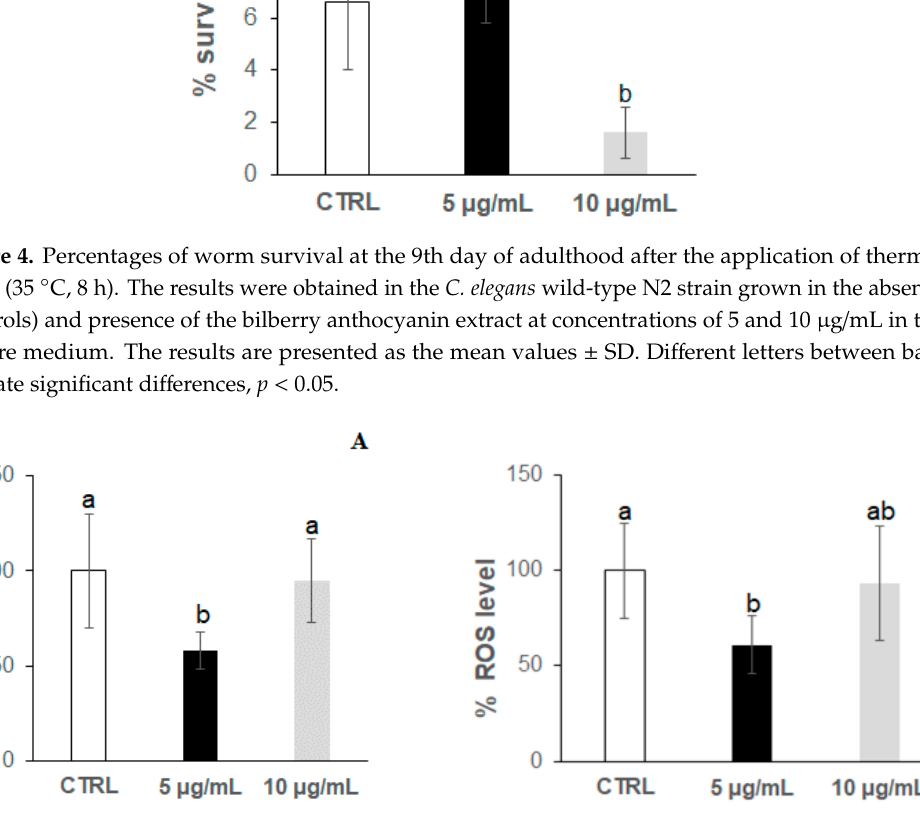
Figure 5. ROS accumulation (expressed as percentage of fluorescence relative to controls) at the 9th day of adulthood in C. elegans wild-type N2 strain grown in the absence (controls) and presence of the bilberry anthocyanin extract at concentrations of 5 and 10 µ g / mL in the culture medium. Results obtained in ( A ) non-stressed worms and ( B ) worms submitted to thermal stress (35 ◦ C, 2 h). In all cases, the assays were carried out in triplicate. The results are presented as the mean values ± SD. Di ff erent letters between bars indicate significant di ff erences, p < 0.05.